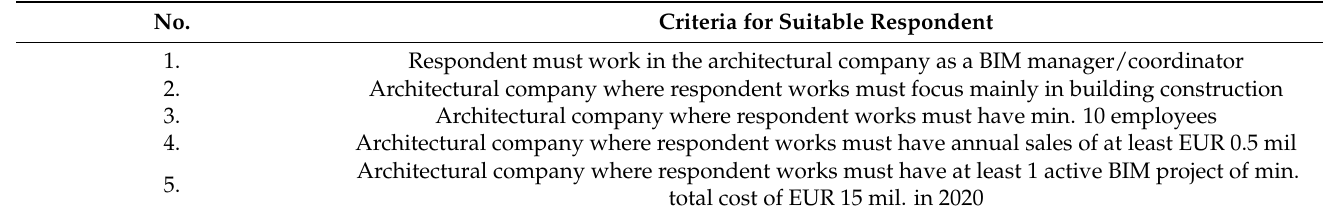
Table 1. Criteria for selection of respondents for a survey.